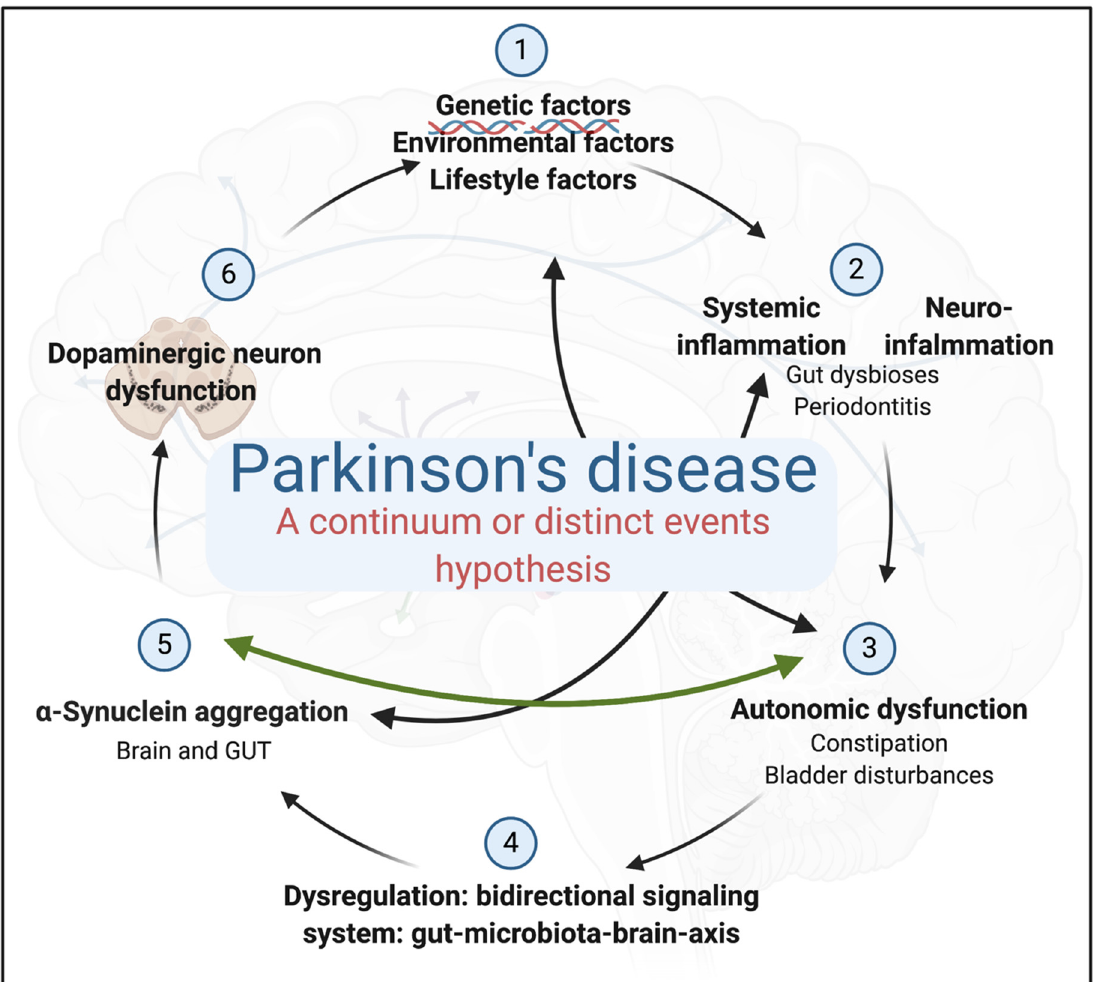
Figure 3. Parkinson’s disease: a continuum or distinct events hypothesis? The condition is characterized by the presence of (1) predisposing genetic, environmental, and lifestyle factors that together contribute to both (2) systemic and neuro- inflammation. (3) Autonomic dysfunction and a (4) dysregulated bidirectional signalling system and (5) α -Syn aggregation are associated with (6) motor and dopaminergic neuron dysfunction. We argue that there is a positive feedback mechanism between (5) α -Syn aggregation and (3) autonomic dysfunction.